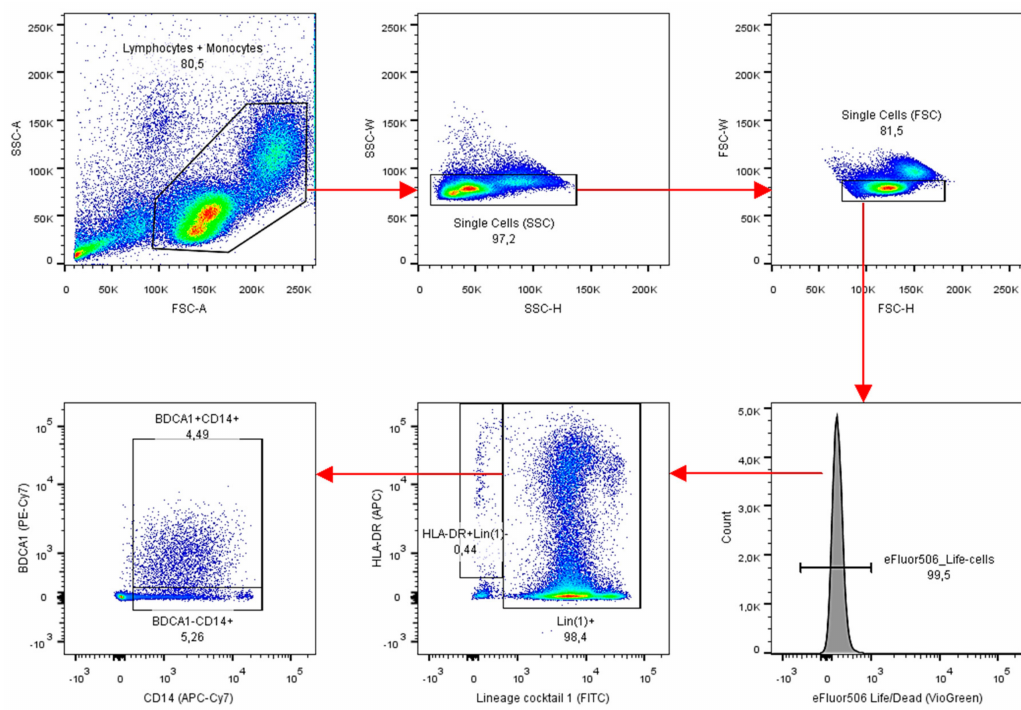
Figure A2. Flow cytometry gating strategy for BDCA1+CD14+ cells in PBMCs of patients with leukemia. Lymphocytes and monocytes were gated based on forward scatter and side scatter; single cells were gated on the basis of side scatter width and side scatter height followed by forward scatter width and forward scatter height; viable cells were eFluor506 negative; BDCA1+CD14+ cells were identified within the population of Lineage-positive and HLA-DR+